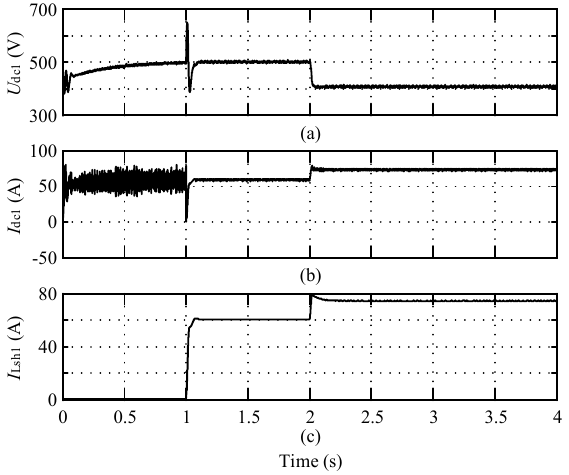
Figure 11. Simulation curve of VSC side of small current bipolar short circuit. ( a ) Capacitor C 1 voltage U dc1 . ( b ) VSC-side cable current I dc1 . ( c) current over current-limiting inductor in FCL1 I Lsh1.